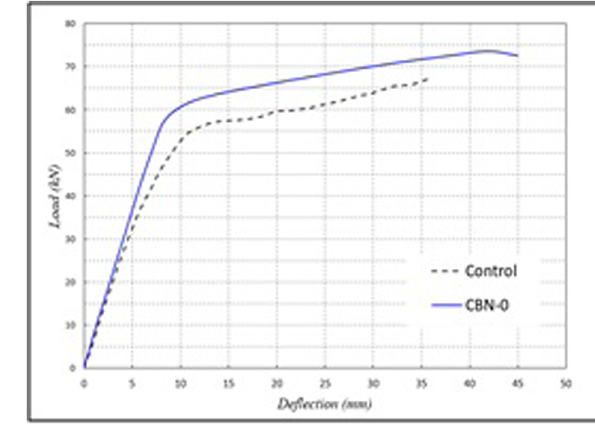
Figure 8: Load – de fl ection curve of control specimen.